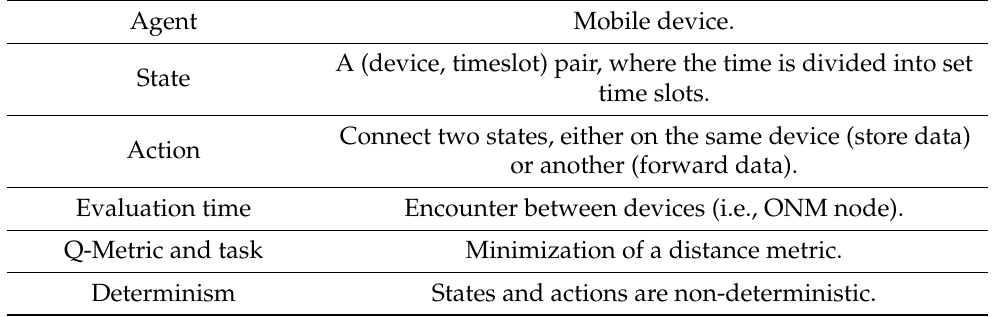
Figure 3. rl4dtn learning model. ( a ) The ONM model with the time slots and the learning agents marked in red; ( b ) Q-learning states ad actions. Each state is associated to a device and time slot; ( c ) The Q-tables for all devices. Table 1. Reinforcement learning structure for rl4dtn